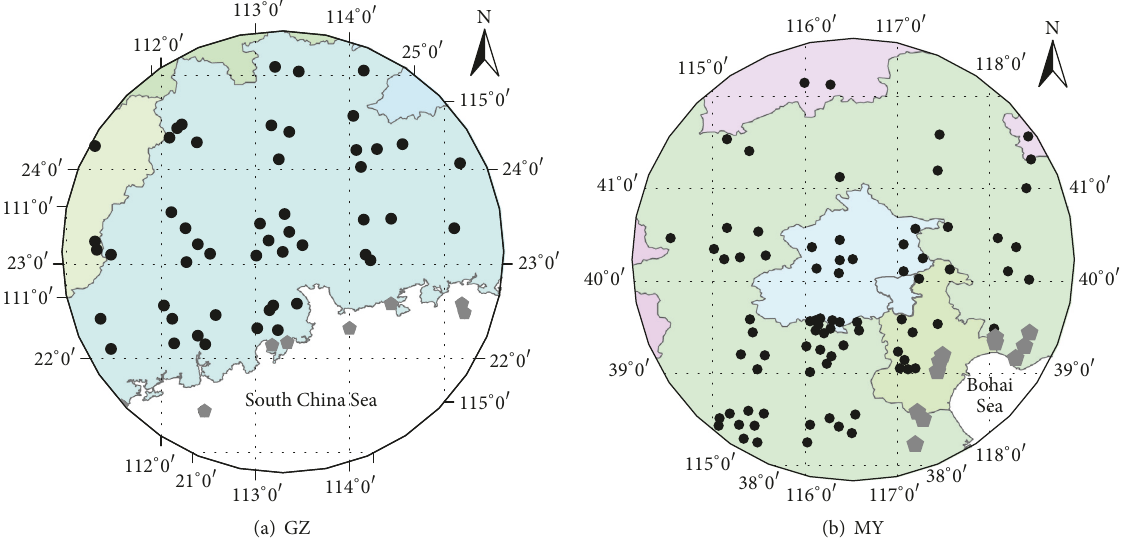
Figure 11: The distribution of stations in (a) Guangzhou and (b) Miyun